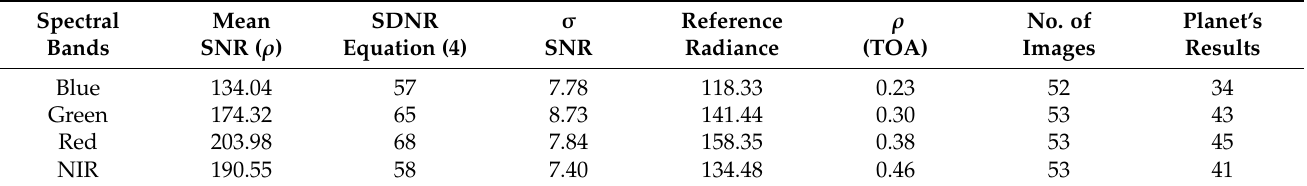
Table 3. SkySat averaged SNR results for products acquired over the Libya-4 test